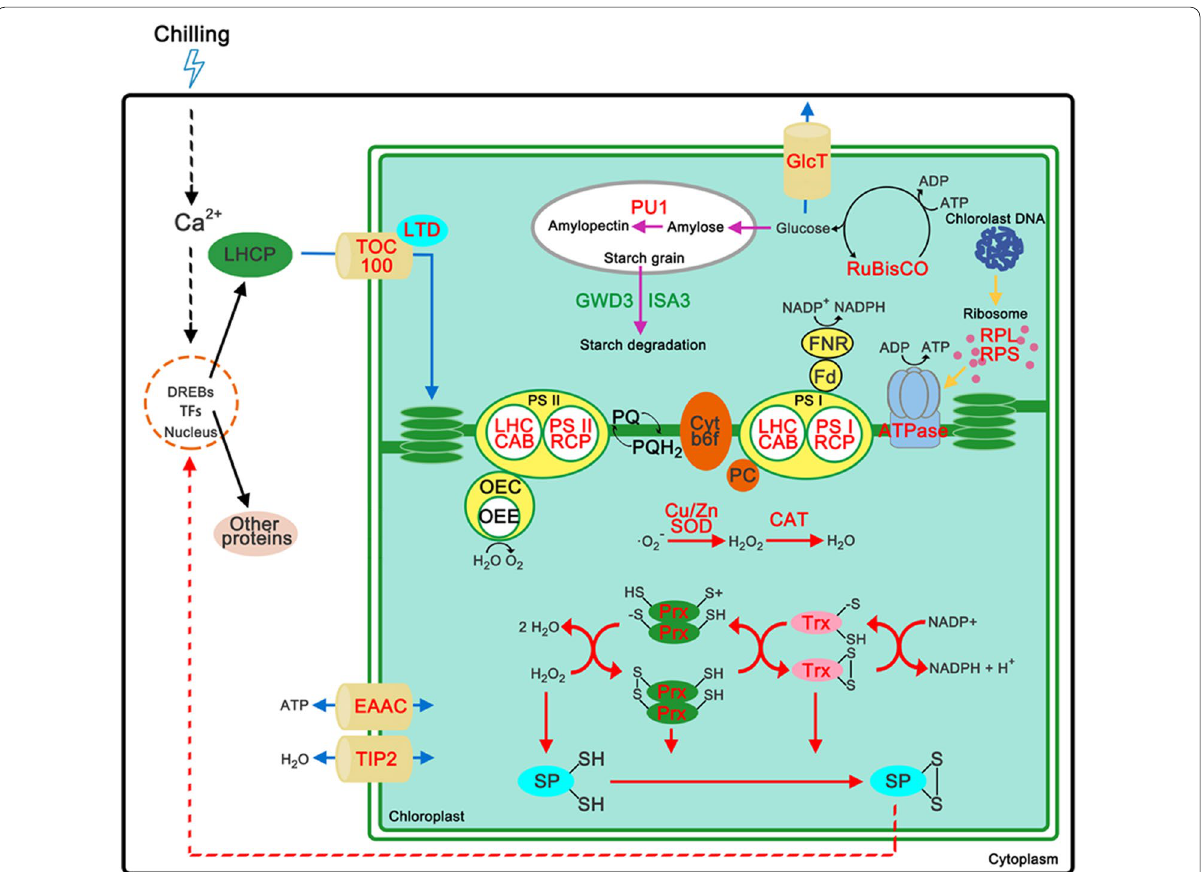
Fig. 7 Schematic presentation of systematic chilling response mechanisms in chloroplast of sugar beet. Red and green letters represent proteins were significantly up- and down-regulated after chilling, respectively. Blue, red, yellow and purple arrows represent transport-related pathway, antioxidant pathway and H 2 O 2 signal, translation from chloroplast DNA and starch metabolism, respectively. The dotted line represents the signal transduction